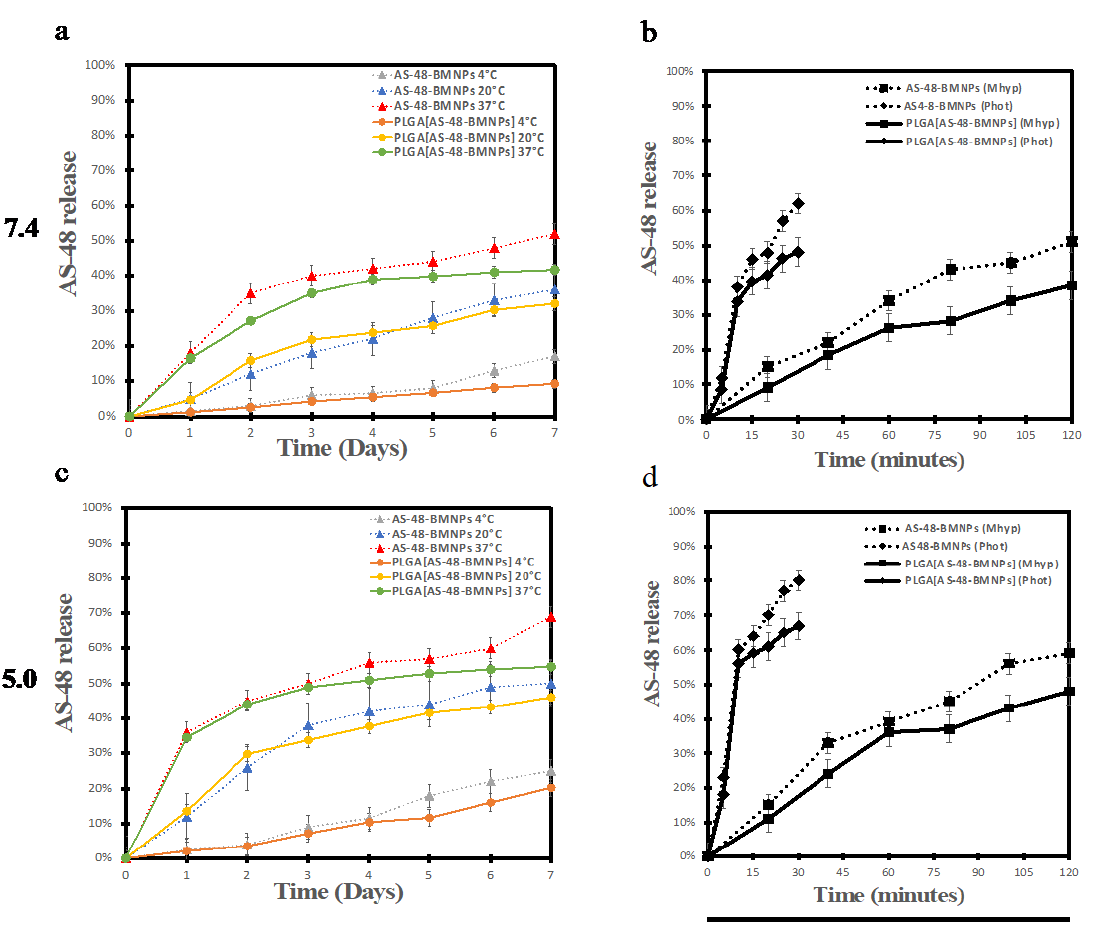
Figure 7. AS-48 released data from PLGA[AS-48-BMNPs] and AS-48-BMNPs in PBS pH 7.2–7.4 ( a ) and in citrate pH 5.0 ( c ) at different temperatures (4, 20, and 37 ◦ C). AS-48 released data from the same nano-formulations following magnetic hyperthermia (Mhyp) and photothermia (Phot)